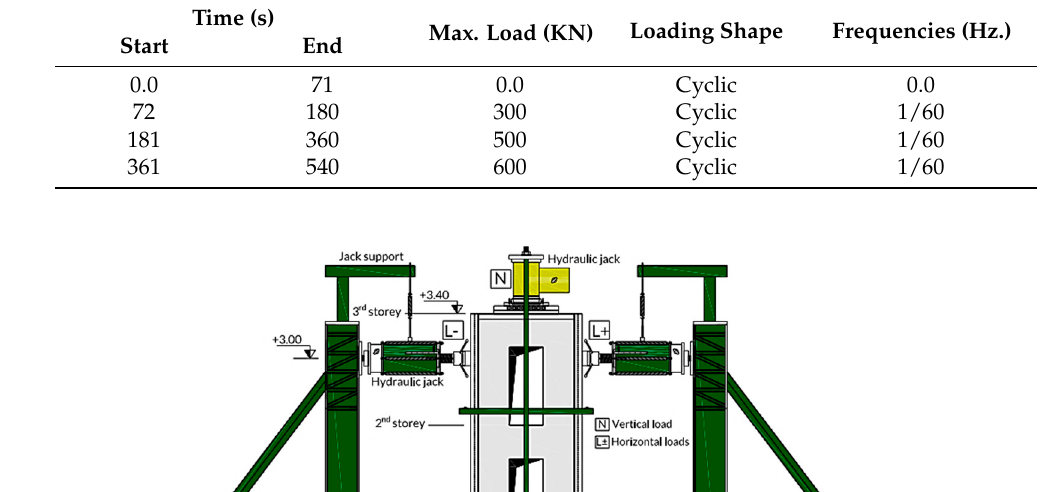
Table 2. Cyclic loading time history.